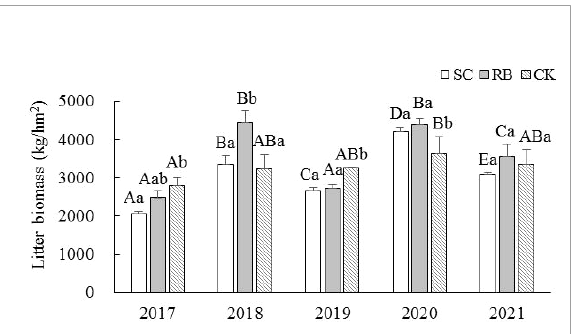
FIGURE 2 Dynamics of litter biomass in strip cut plot (SC), reserved belt (RB), and control plots (CK). Error bars represent standard deviation (n=3). Different capital letters indicate a signi fi cant difference in litter biomass between the different treatment plots at the same time ( p < 0.05); Different lowercase letters indicate a signi fi cant difference in litter biomass between the different times in the same treatment plot ( p <